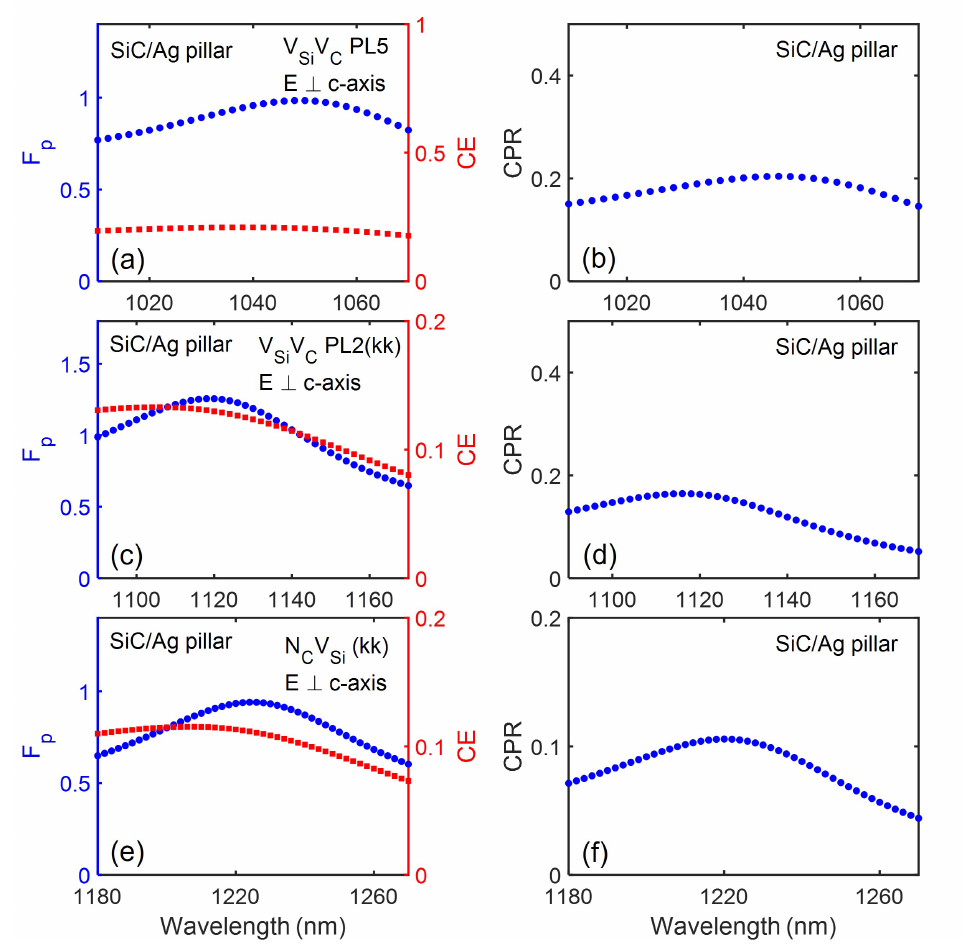
Figure 4. The modified Purcell factor, F p and collection efficiency, CE ( a , c , e ) ; the corresponding CPR performance for various point defect emitters in SiC pillar ( b , d , f ). The specified color centres dipole is located 20 nm below the Ag cylinder surface with the given